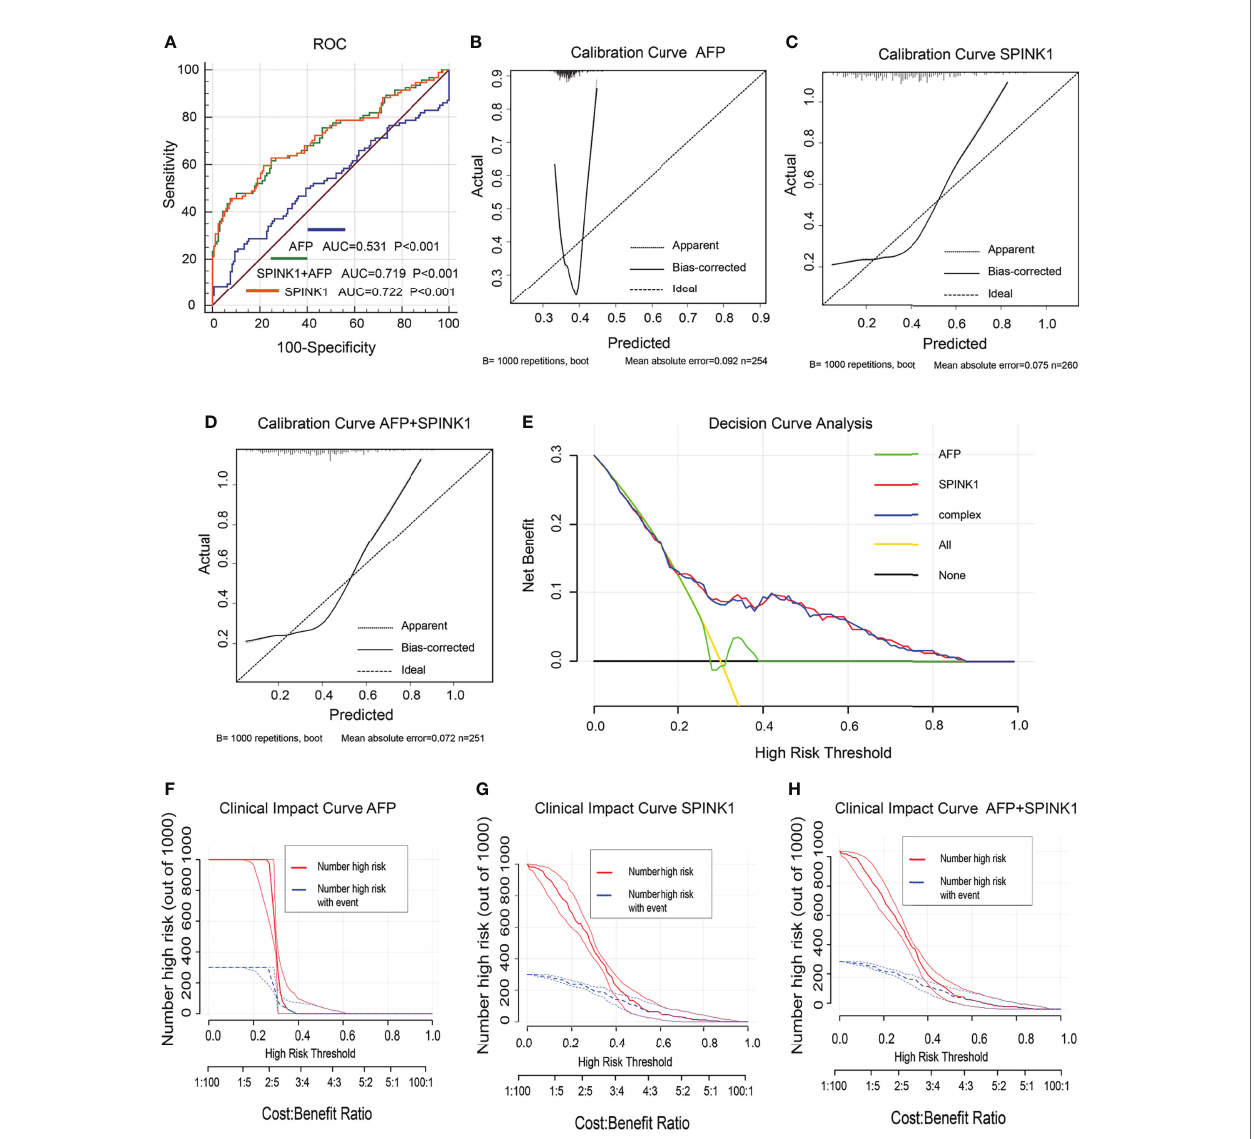
FIGURE 4 | Discrimination and calibration of hepatocellular carcinoma (HCC) prediction models via proteomics analyses in the training dataset. (A) Receiver operating characteristic (ROC) curves and area under the curve (AUC) in the SPINK1 , SPINK1 plus alpha-fetoprotein (AFP), and AFP models. (B – D) Calibration curves of AFP (B) , SPINK1 (C) , and SPINK1 +AFP (D) . (E) Comparison of the decision curve analysis (DCA) of SPINK1 , SPINK1 +AFP, and AFP in terms of clinical net bene fi ts. (F – H) Clinical bene fi ts obtained from the clinical impact curve (CIC) analysis of each detection